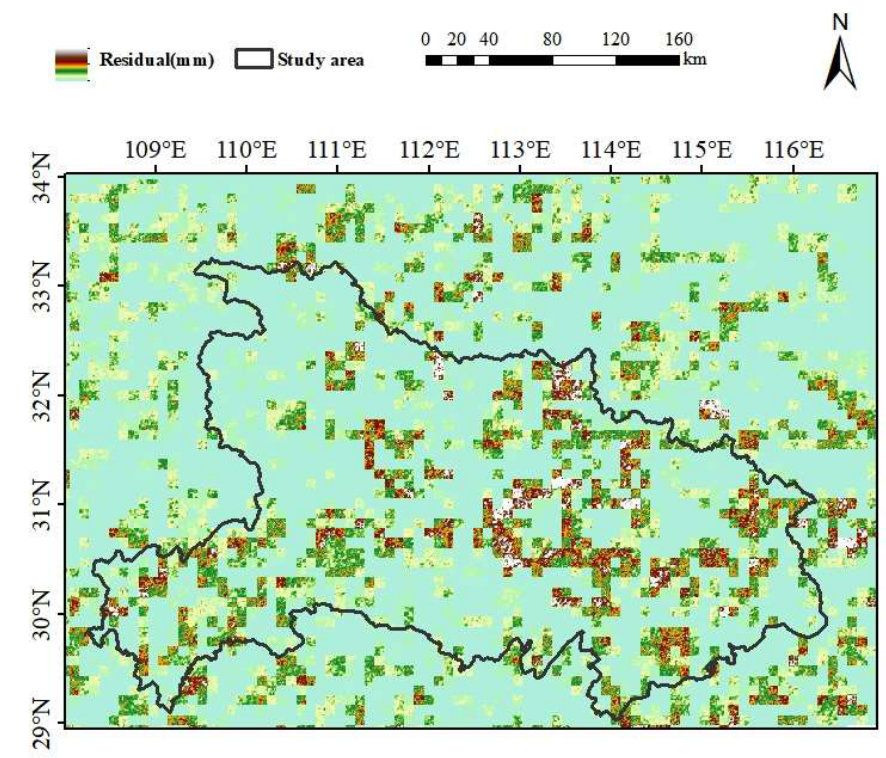
Figure 10. Result of residual interpolation of MFRC model in July 2016.